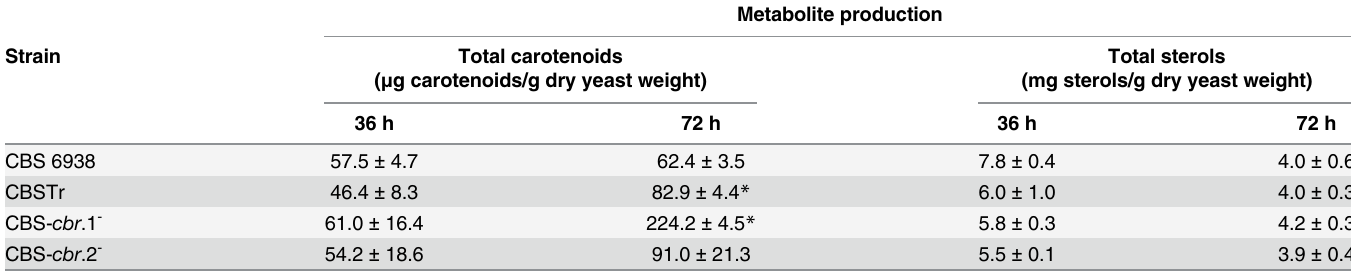
Table 2. Carotenoids and sterols produced by the X . dendrorhous strains cultured in parallel after 36 and 72 h of